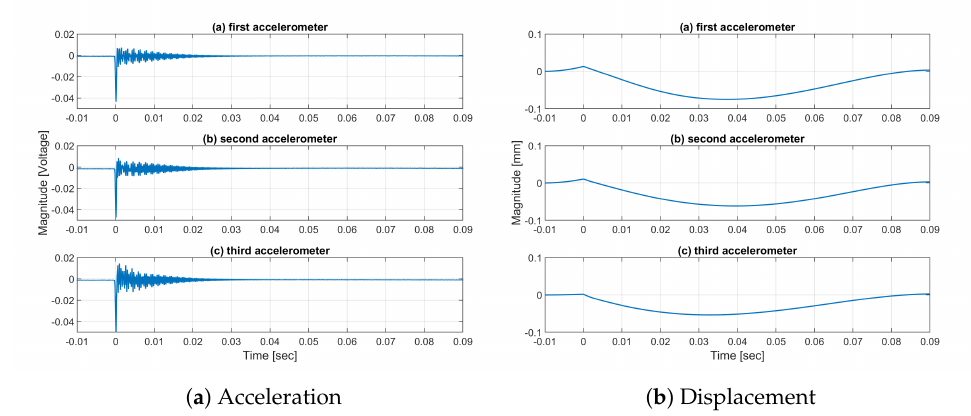
Figure 12. Typical acceleration and displacement results of the 25 mm glued 120 grit wheel.